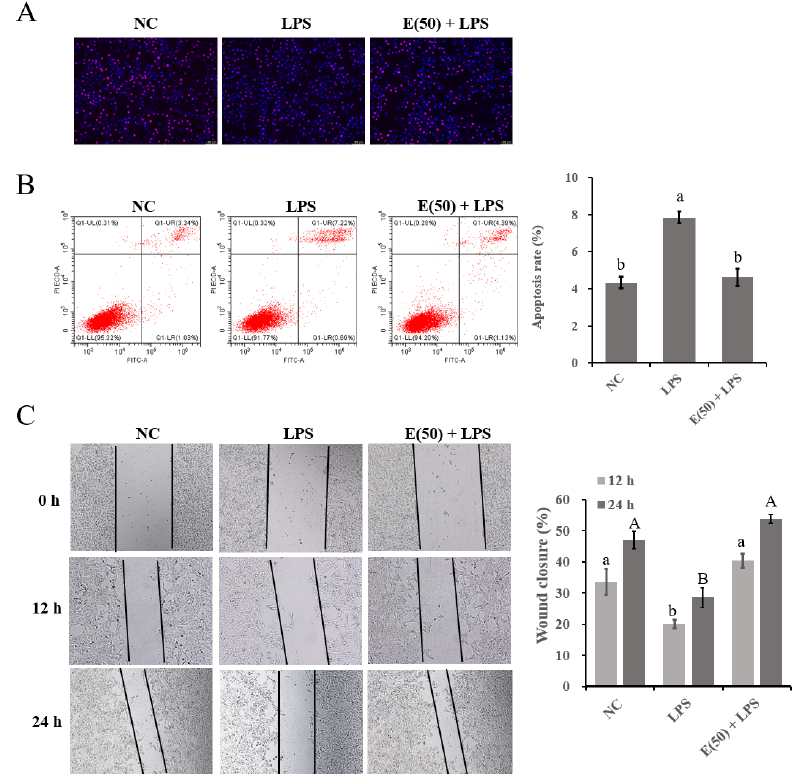
Figure 2. The effect of EGCG pretreatment on cell proliferation followed by LPS stimulation. The concentration and timing of EGCG treatment of cells were selected as 24 h at a concentration of 50 µ M. ( A ) EdU determination for cell proliferation. Cells were observed at 200 × magnification. ( B ) Apoptotic cells were examined using flow cytometry. Apoptotic rate were calculated with the value of early—and late—apoptotic cells. ( C ) Wound-healing assay was performed for the migration ability of hepatocytes and the closure rate was imaged at 0, 12, and 24 h after scraping. Cells were pretreated with EGCG at a dose of 50 µ M for 24 h, followed by the induction of 6 µ g/mL LPS for 6 h. Results are expressed as means ± S.E.M. Letters in lowercase indicate differences between groups at 12 h, while uppercase indicates differences between groups at 24 h ( p < 0.05).